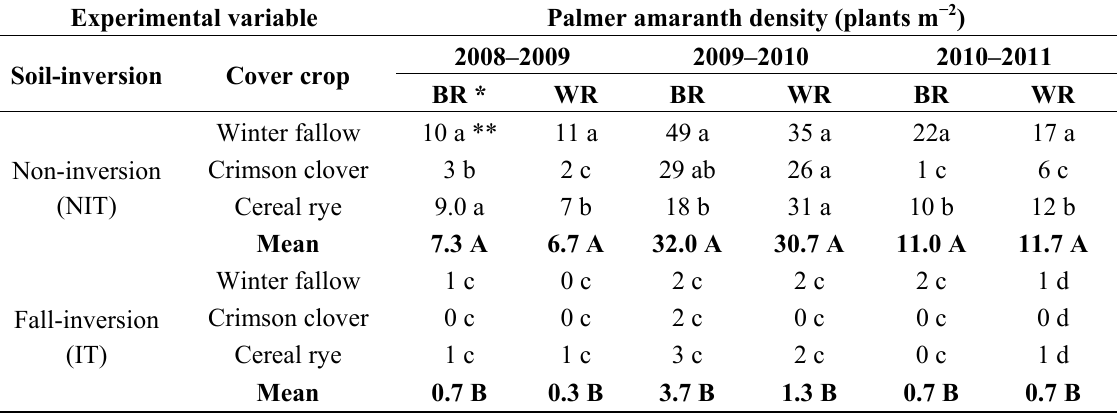
Table 2. Influence of soil-inversion and cover crop on Palmer amaranth density at 2 WAP over three production